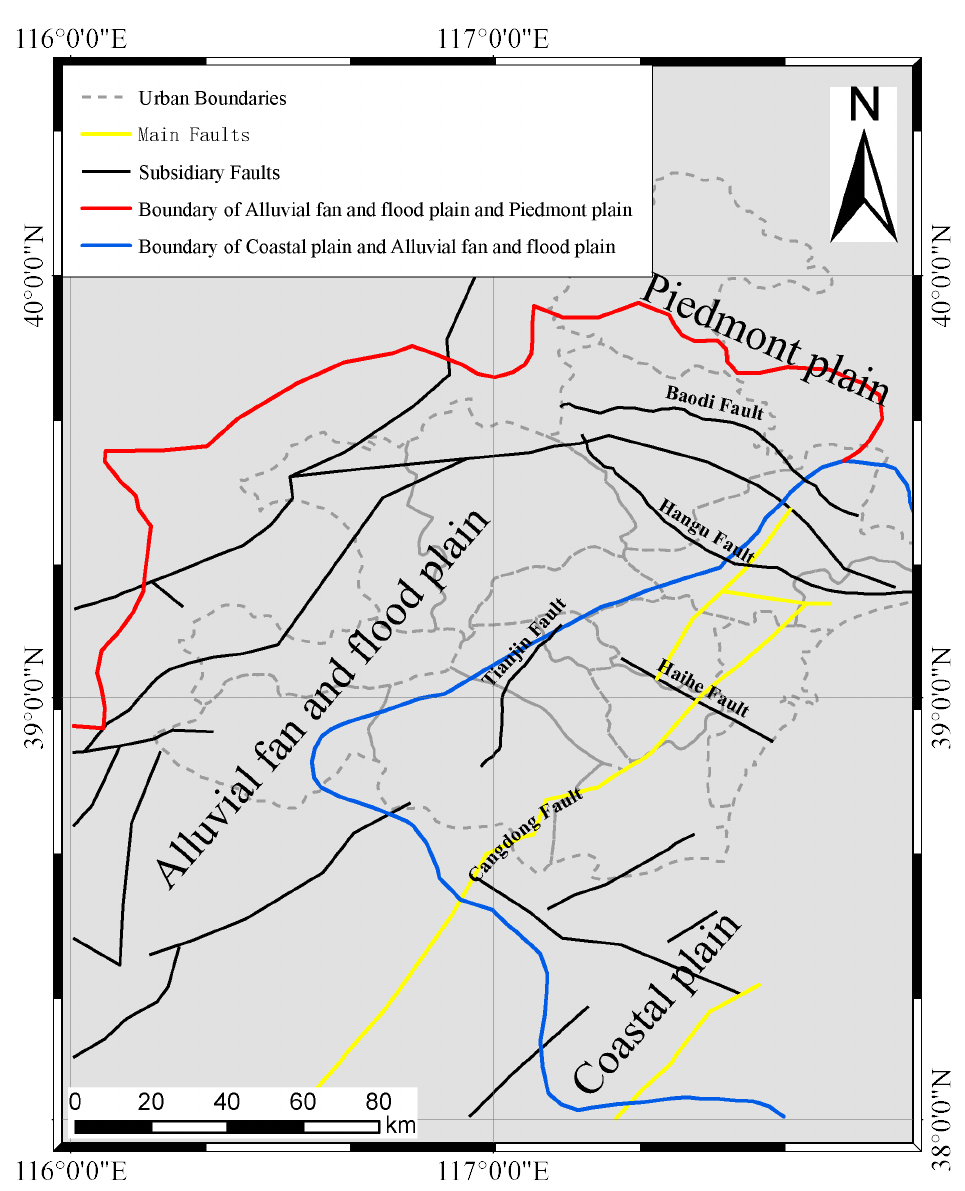
Figure 2. The tectonic framework of the study area. Piedmont plain, alluvial fan and flood plain, and coastal plain in North China Plain are bounded by thick red and blue lines. Major faults and subsidiary faults are shown in thick yellow and black solid lines, respectively. (Revised from